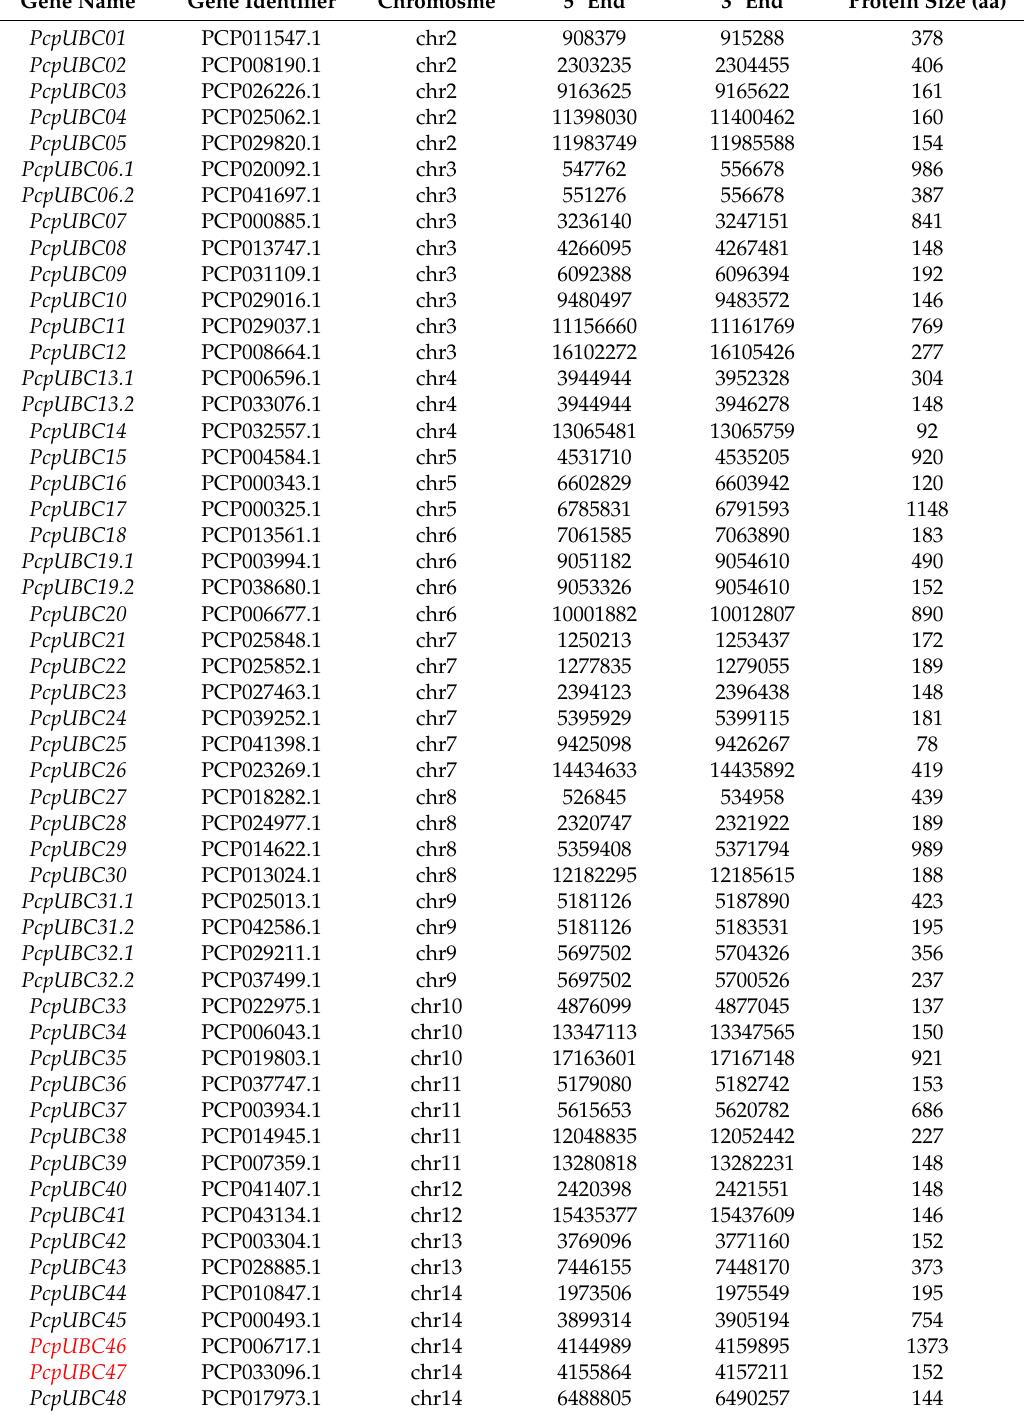
Table 1. The detailed information of UBC family members in both P. bretschneideri and P.